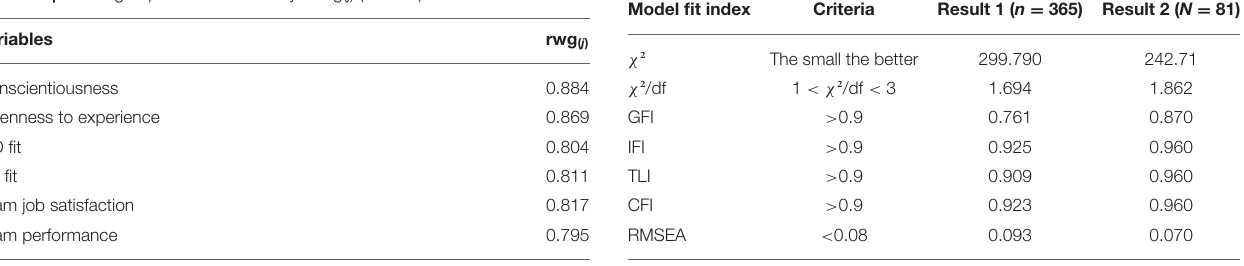
TABLE 4 | Within-group interrater reliability—rwg(j) ( N = 81).